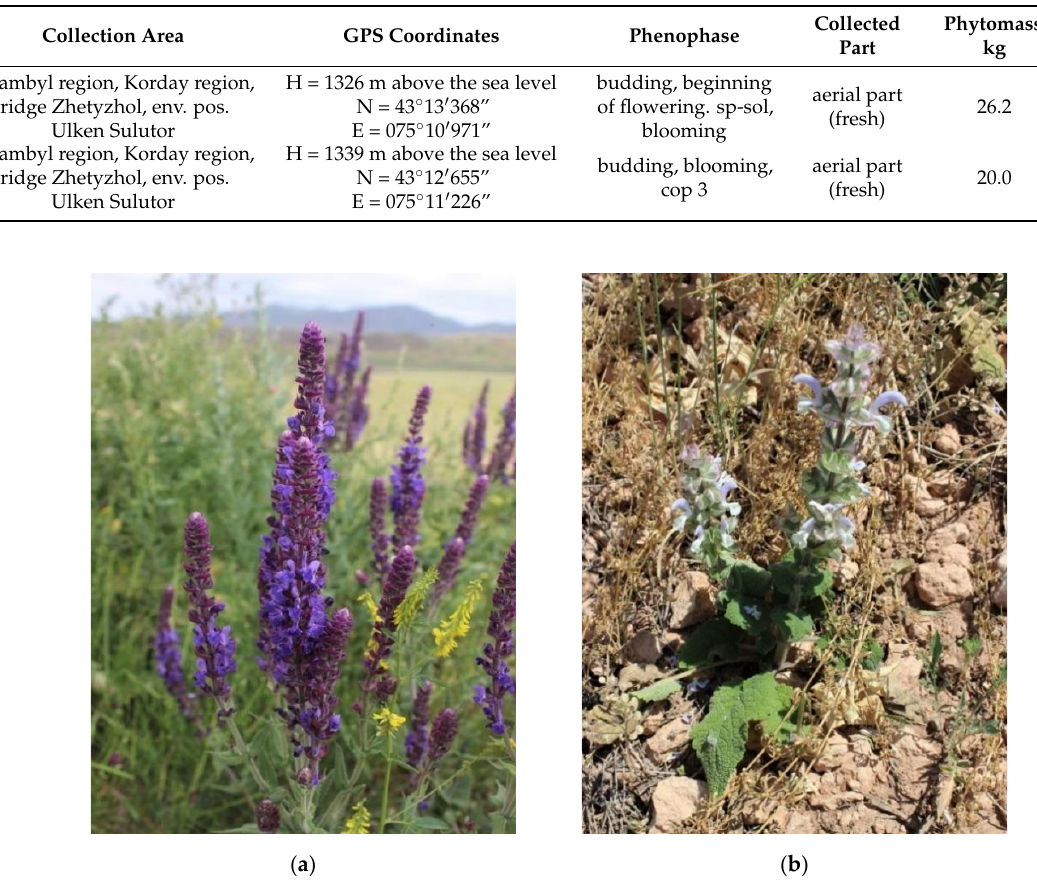
Table 5. Coordinates of the collection of plant materials.